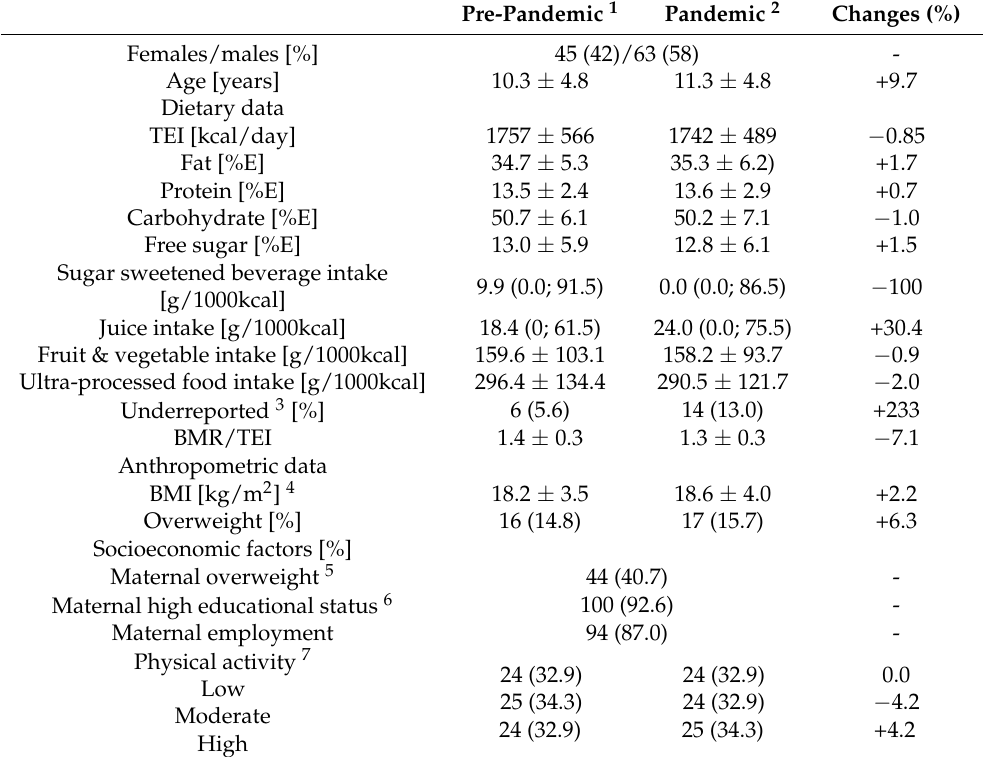
Table 2. Pre-pandemic and pandemic characteristics of the DONALD participants (3–18 years; males: n = 63; females: n = 45): dietary, anthropometric and physical activity data as well as socioeco- nomic